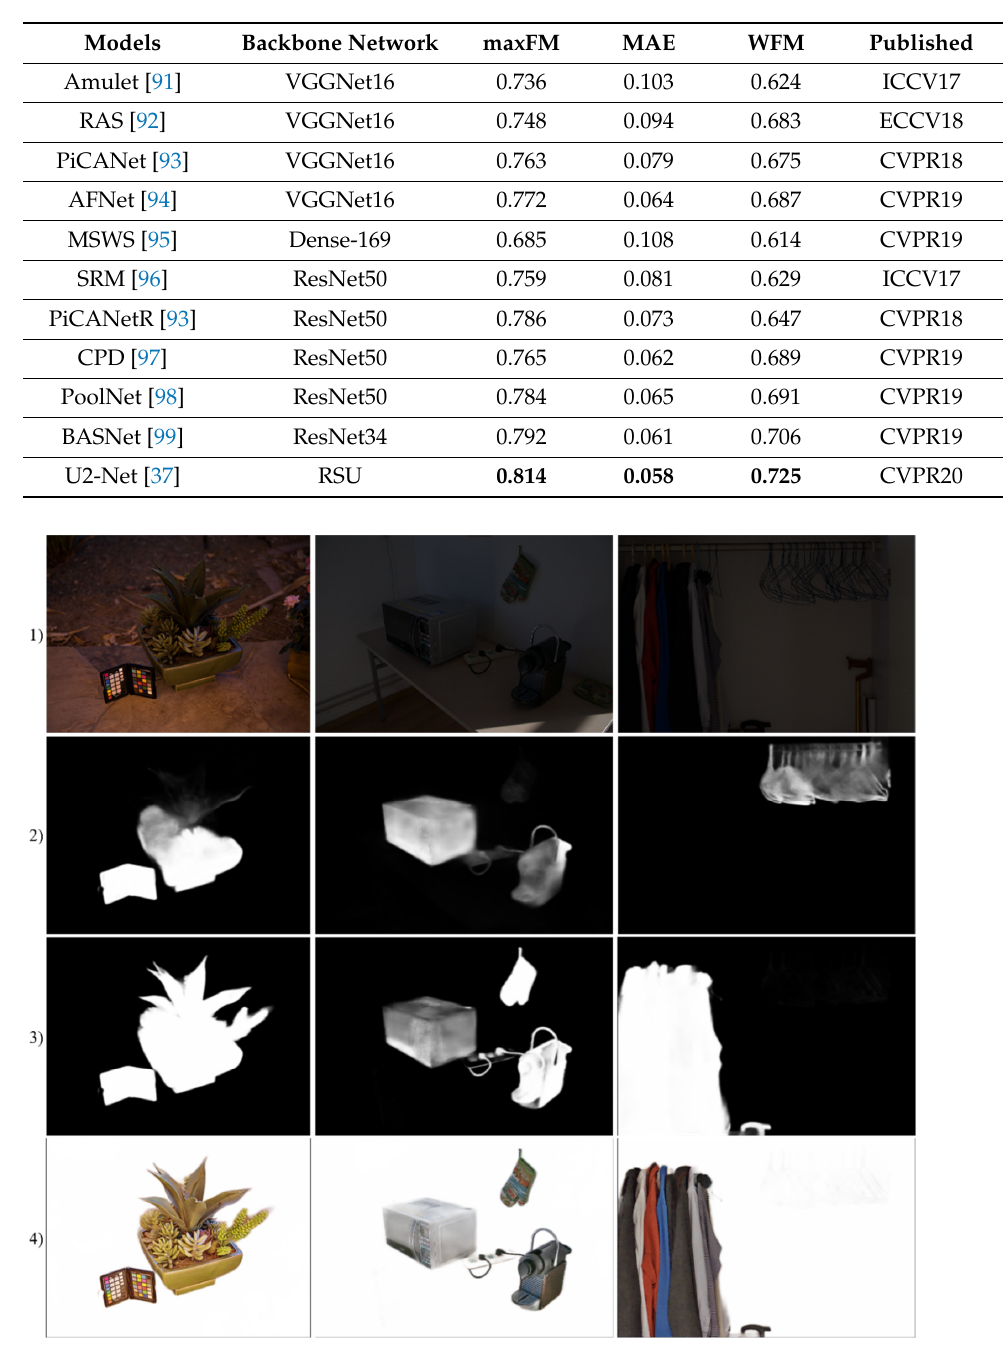
Table 5. The performance comparison of U2-Net with other state-of-the-art models on LOL and ExDark datasets. The best results are marked in bold.